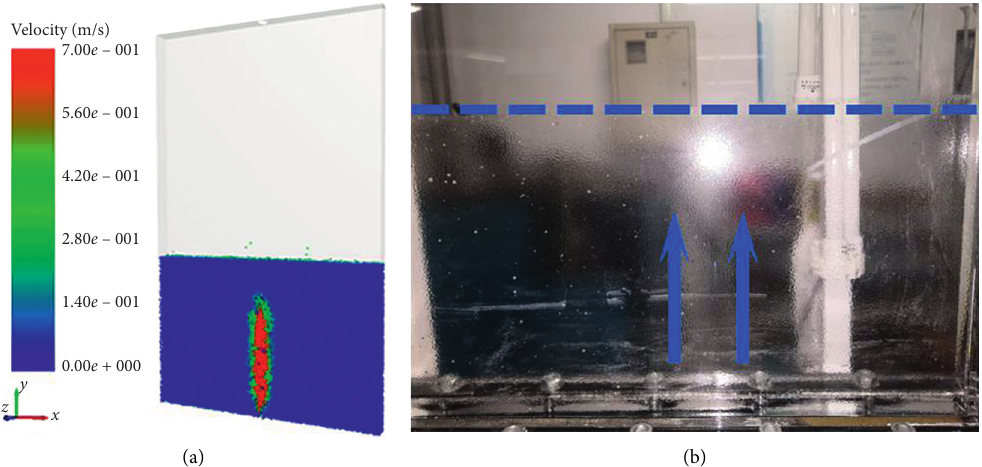
Velocity (m/s) 7.00 e – 001